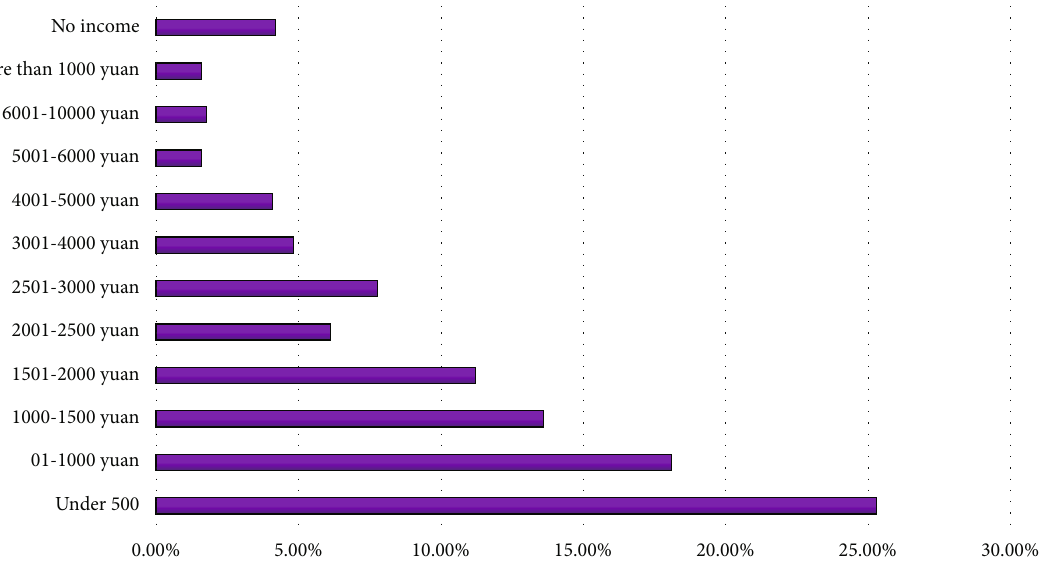
Figure 8: Monthly income distribution of Internet